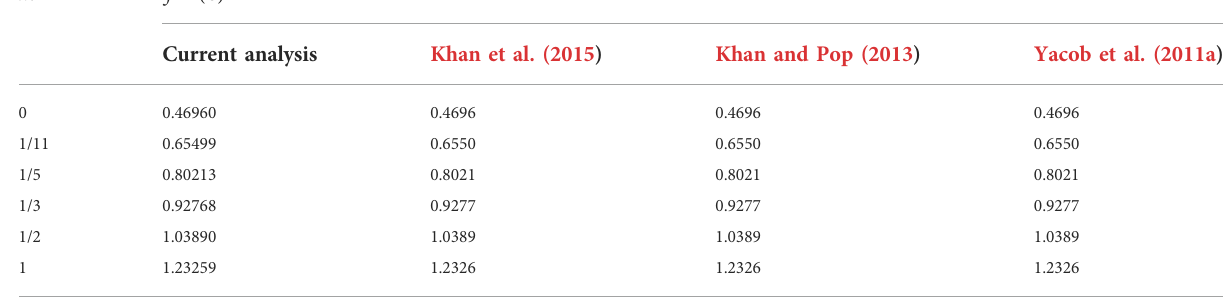
TABLE 2 Comparative study on skin friction for α (cid:1) 0and λ (cid:1) M (cid:1) 0. m f @ ( 0 ) Current analysis